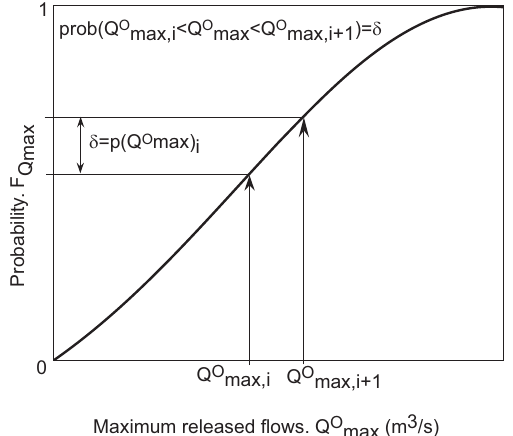
Fig. 3. Probabilities involved in the determination of Iq and Iv .